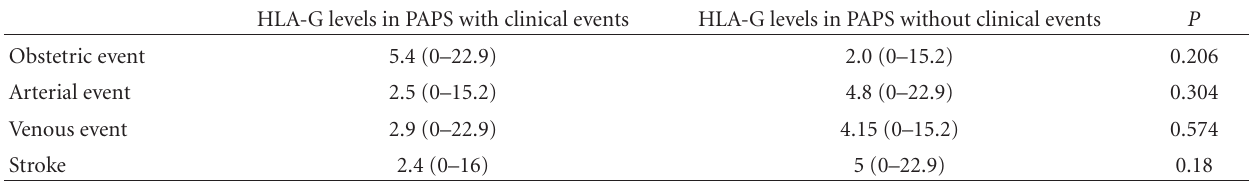
Table 2: Comparison of HLA-G levels between primary antiphospholipid syndrome patients (PAPS) with and without clinical events. HLA-G levels in PAPS with clinical events